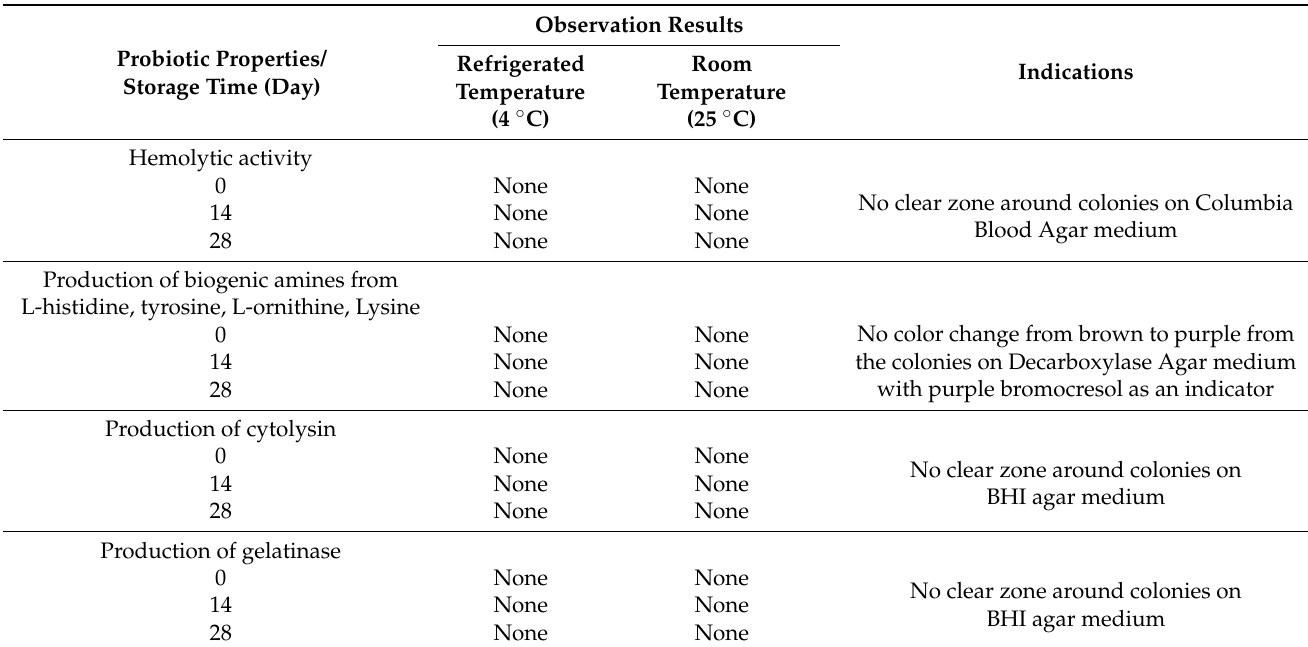
Table 2. Safety evaluation of Lactobacillus fermentum InaCC B1295 in CMFH-OPEFB at various temperatures for 28 days.